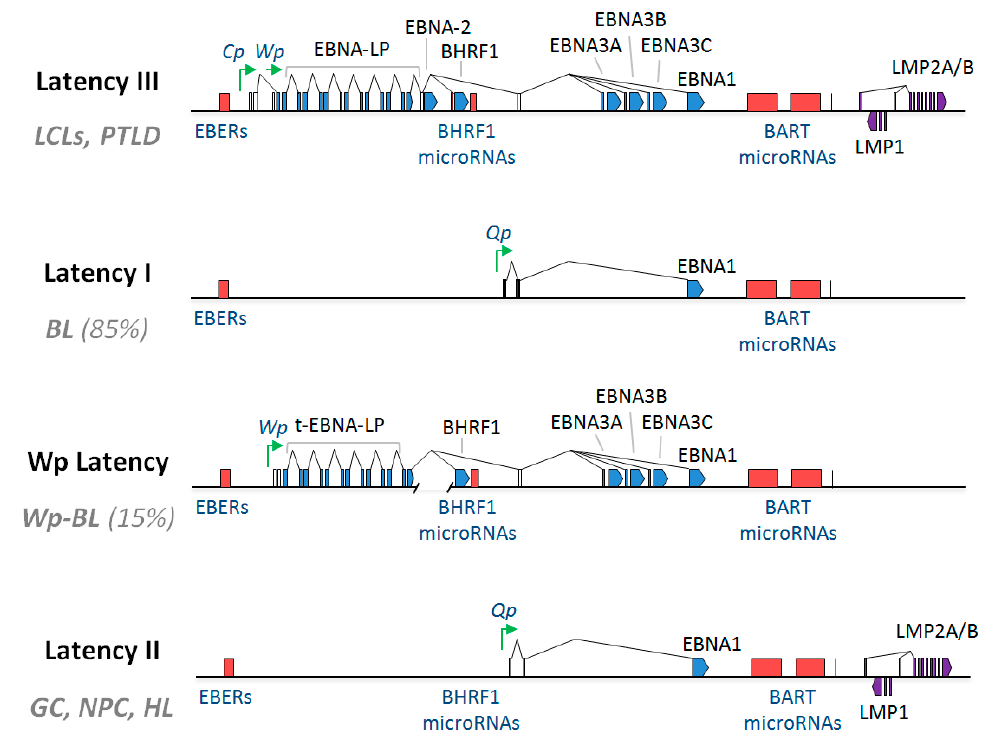
Figure 1. Patterns of latent gene expression found in Epstein–Barr virus (EBV)-associated malignancies and growth transformed B cell lines. Schematic showing: the Latency III EBV gene expression programme, as found in B cells transformed in vitro into lymphoblastoid cell lines (LCLs); Latency I EBV gene expression as found in the majority (85%) of EBV-positive Burkitt lymphomas (BL); Wp-restricted latency (Wp Latency), as found in a minority (15%) of EBV-positive BLs (termed Wp-BL); and Latency II EBV gene expression, which is found in EBV-positive Hodgkin lymphoma (HL) as well as the EBV-associated epithelial malignancies, nasopharyngeal carcinoma (NPC) and gastric carcinoma (GC). Latent proteins (EBNA1, EBNA2, EBNA3A, EBNA3B, EBNA3C, EBNA-LP, BHRF1, LMP1 and LMP2A/B) are shown in blue. Non-coding RNAs (EBERs, miR-BHRF1s and miR-BARTs) are shown in red, and selected latent promoters (Cp, Wp and Qp) are shown in green. Connecting lines denote splicing patterns, whilst blocks indicate exons. In Wp-BL, EBNA-LP is truncated due to a genomic deletion and is therefore denoted as t-EBNA-LP.